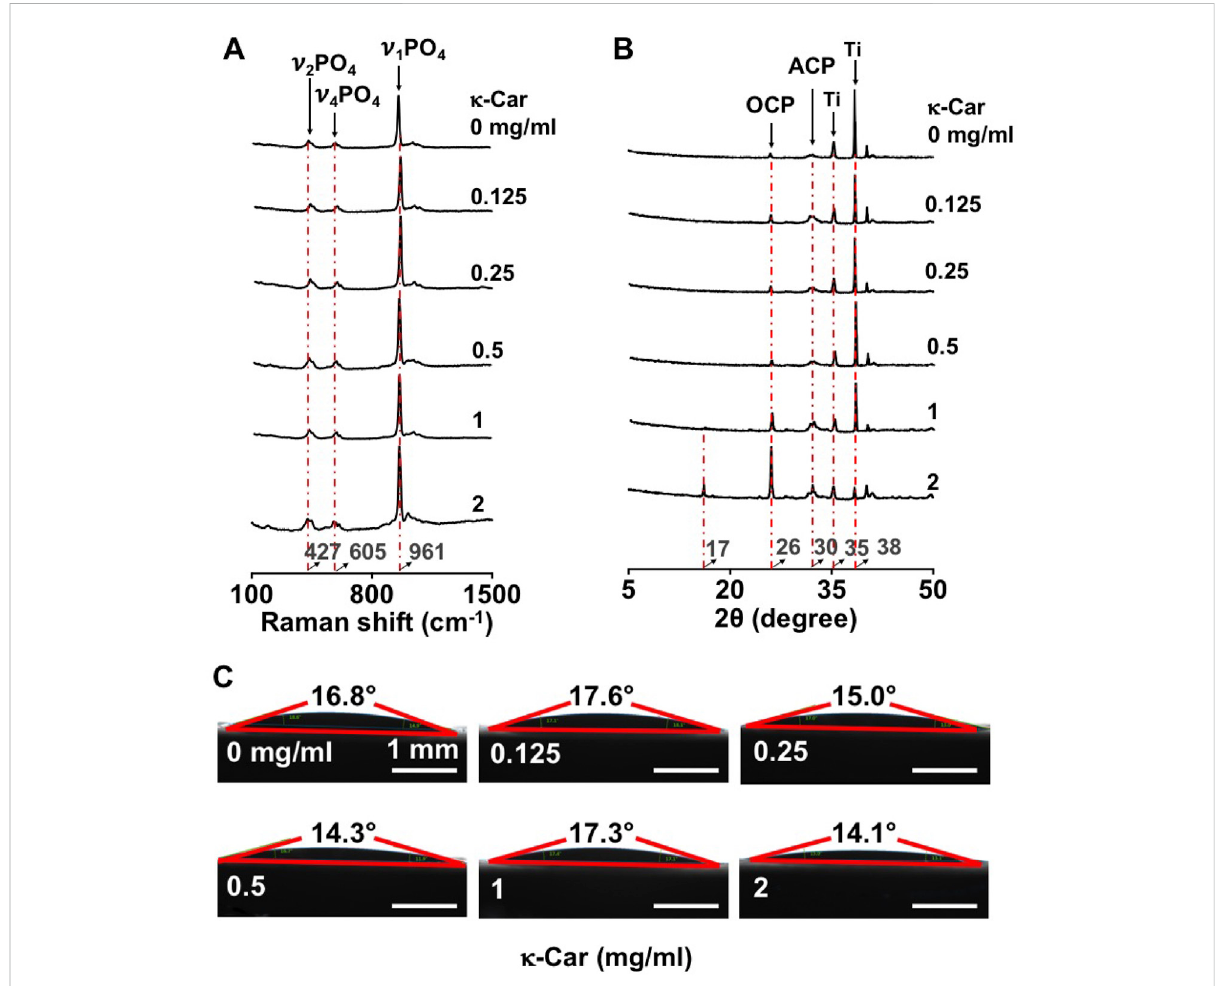
FIGURE 2 Effect of κ -carrageenan in OCP-coating of titanium discs on the crystalline phase and surface hydrophilicity of OCP-coating. (A) Raman spectra. (B) XRD spectra. (C) Surface hydrophilicity. κ -Car, κ -carrageenan. Bar: 1 mm.